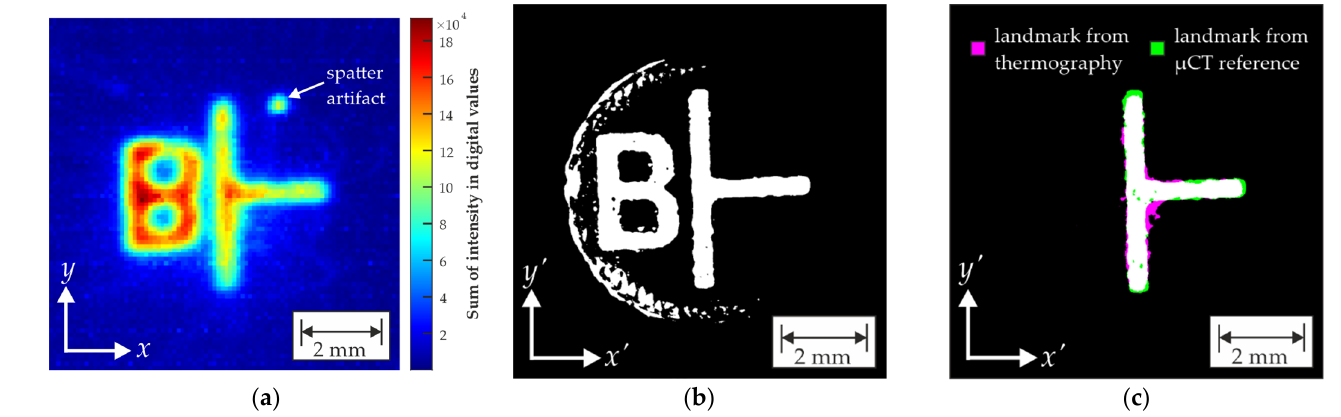
Figure 8. ( a ) Sum of temperature image from the raw 4D thermogram dataset. ( b ) x’ - y’ slice of V bin at a height of z’ = 1205 vox. ( c ) Extracted and processed cross labels from ( a , b ) after the spatial registration was performed. Shown here is a monomodal translation registration with a quality of 0.958 calculated by the MATLAB Registration Estimator Toolbox. White areas correspond to overlapping area, while pink and green correspond to deviating areas.